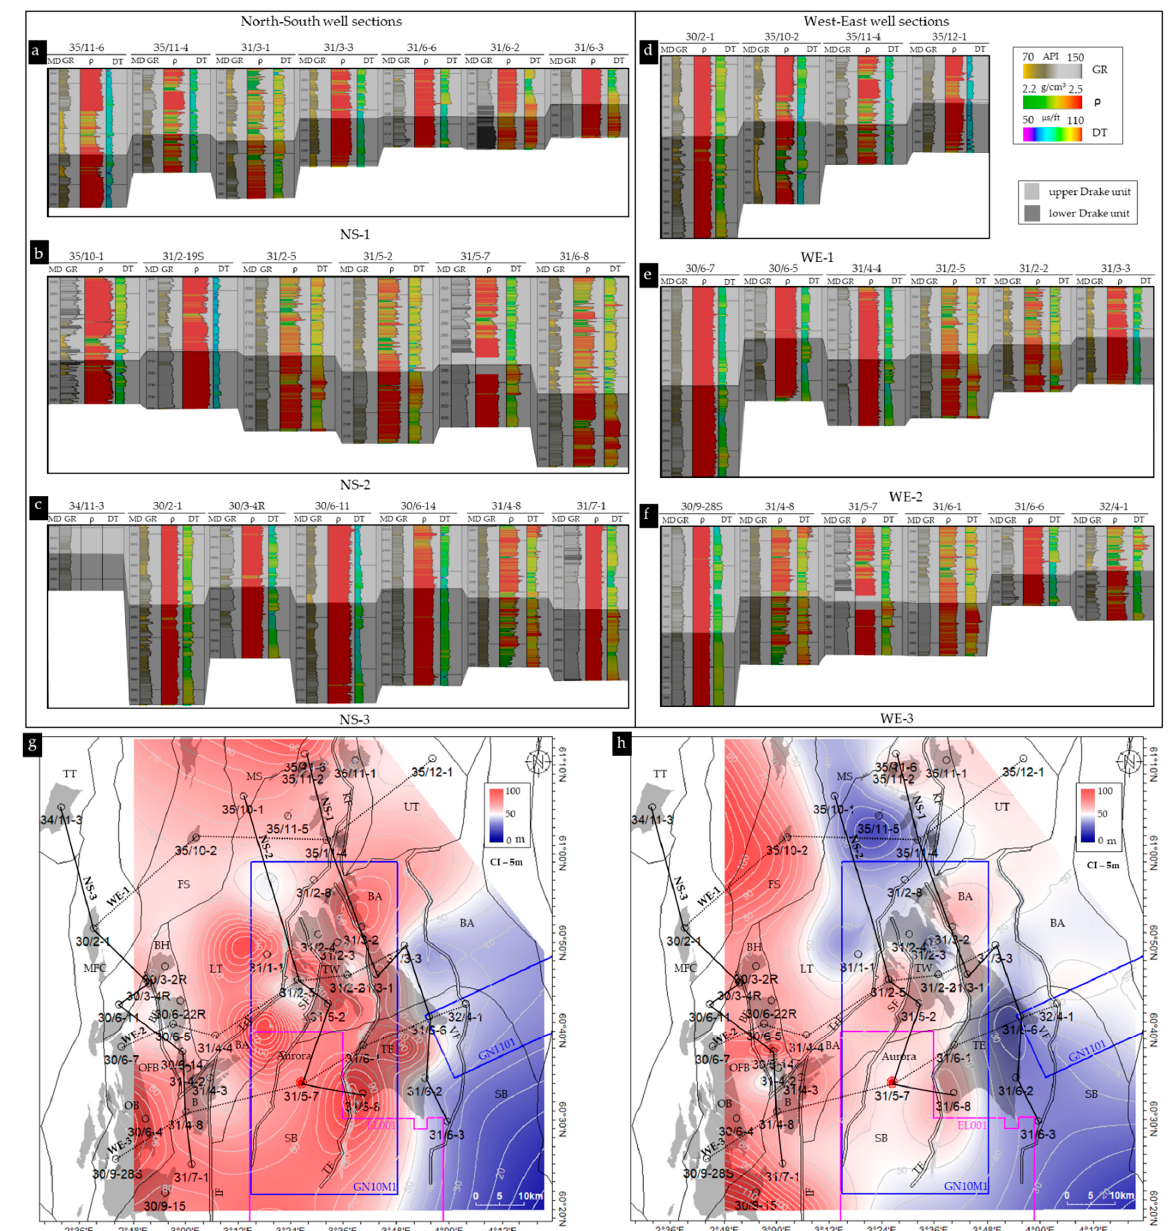
Figure 8. Well sections flattened on top of the upper Drake unit representing thickness and property variations in wells covering the north–south ( a – c ) and the east–west directions ( d – f ) in the study area. The thickness maps of the upper Drake ( g ) and lower Drake ( h ) units exhibit the correlation profiles’ locations and show the study area’s overall variation. Color legend used to displayed wireline logs is also shown.